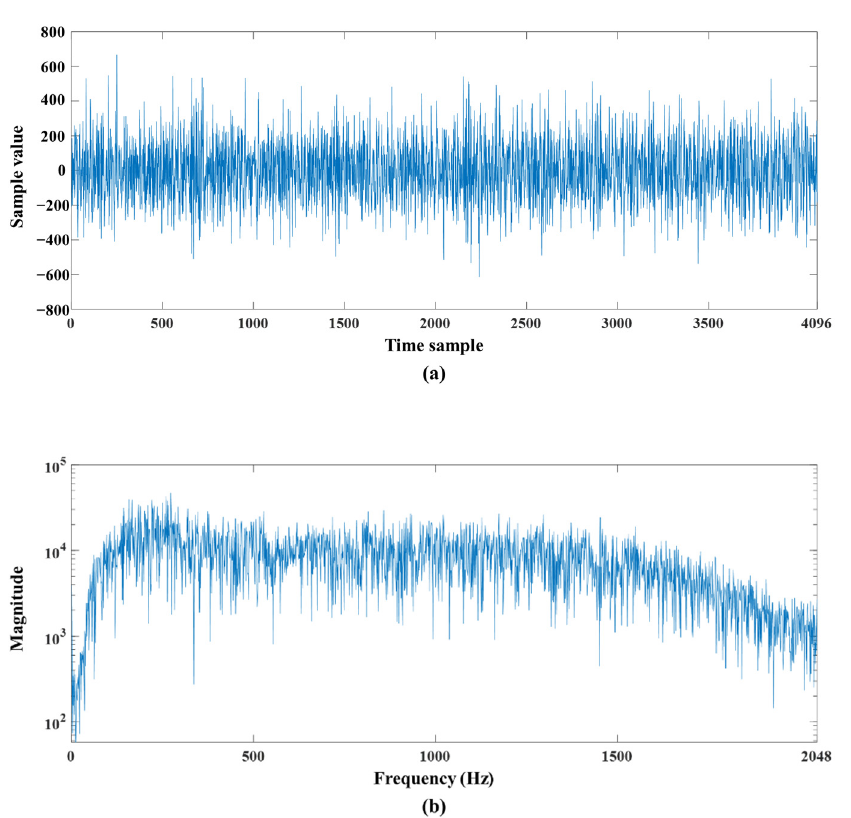
Figure 3. Examples of acquired sensor signals represented in ( a ) time domain and ( b ) frequency domain.